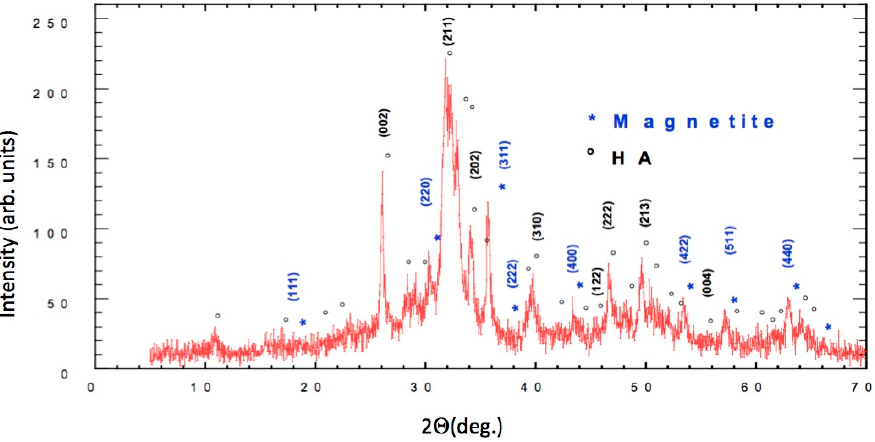
Figure 1. Cu K α diffractogram of the synthetized nano-Hydroxyapatite (nHA), ( * ) Magnetite reflections, ( ◦ ) nHA reflections.